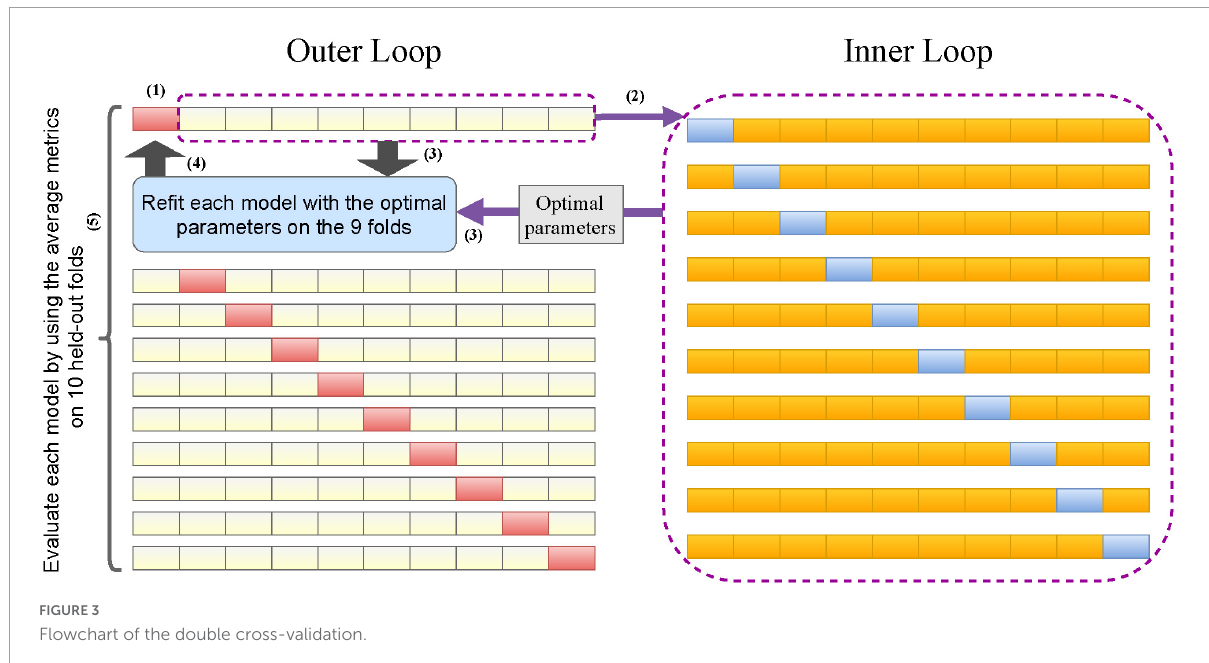
FIGURE3 Flowchart of the double